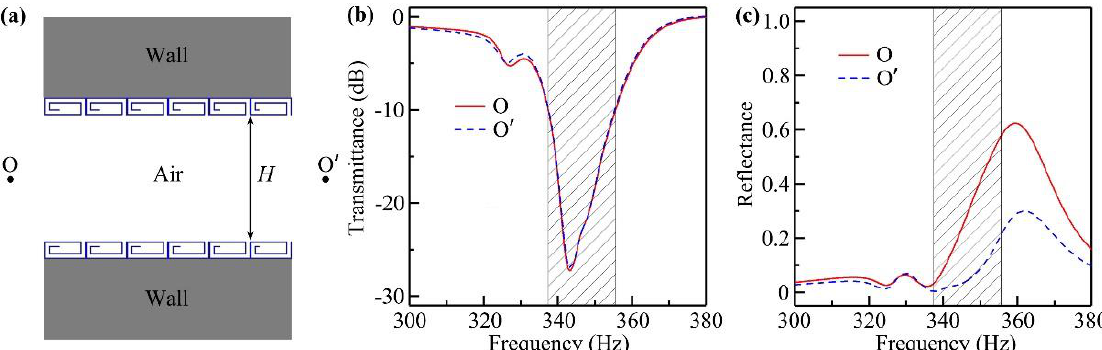
Figure 3. ( a ) Schematic of a tunnel structure with low-frequency low-reflection BSI. A cylindrical sound source is separately placed at the point O or O ′ . The tunnel width H is 343 mm. The distance between the sound source and adjacent tunnel entrance is 100 mm. We simulated ( b ) transmittance and ( c ) reflectance spectra through the tunnel by separately placing a cylindrical sound source at the points O and O ′ . Black shaded regions show the sound transmittances below −10 dB.